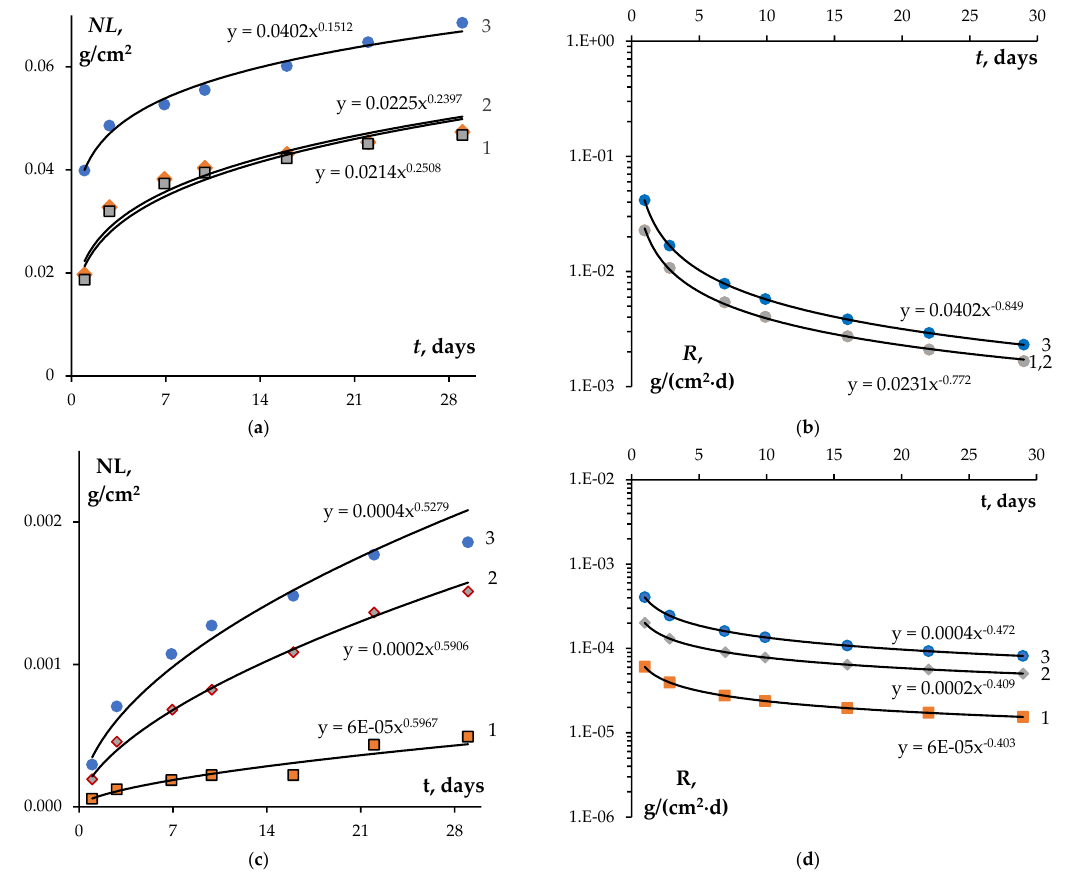
Figure 10. Dependence of normalized weight loss ( NL ) ( a , c ) and leaching rate ( R ) ( b , d ) on testing time t for the Na 0.5 Zr 2 (PO 4 ) 2.5 (MoO 4 ) 0.5 ( a , b ) and Na 0.5 Zr 2 (PO 4 ) 2.5 (WO 4 ) 0.5 ( c , d ) ceramic specimens. Fluence: 1 – 3·10 12 cm −2 , 2 – 1·10 13 cm −2 , 3 – 3·10 13 cm −2 .